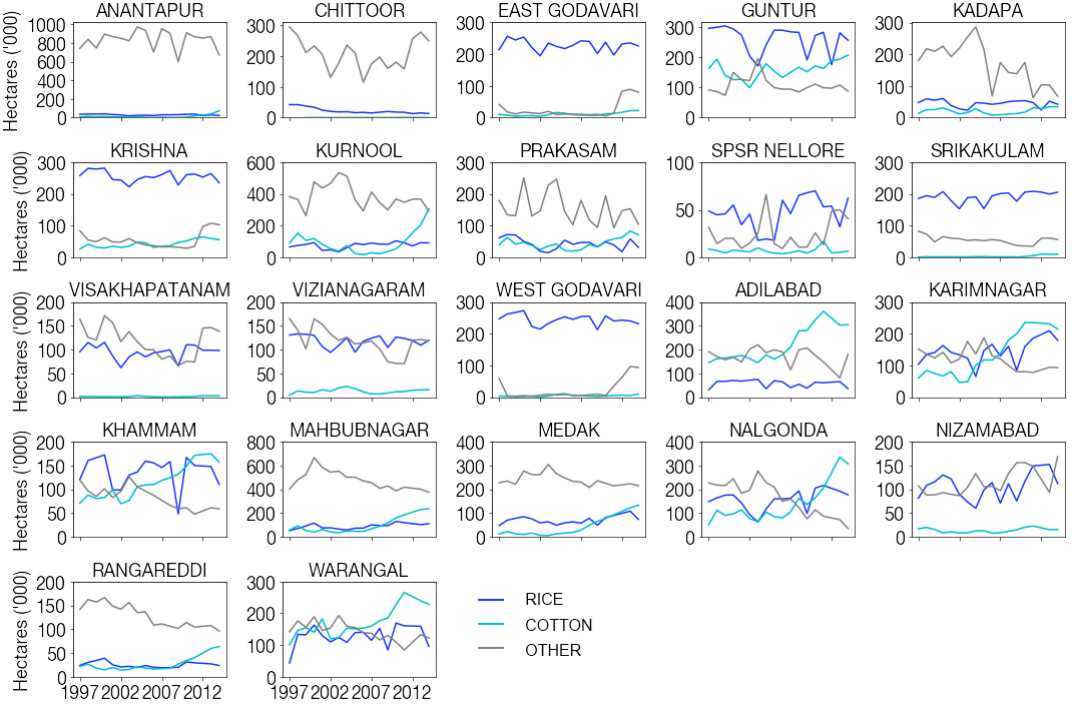
Figure A18. District-level kharif crop area in Andhra Pradesh and Telangana from 1997–2014. Area data were downloaded from data.gov.in and are shown for rice, cotton, and other, where other shows the sum of non-rice and non-cotton